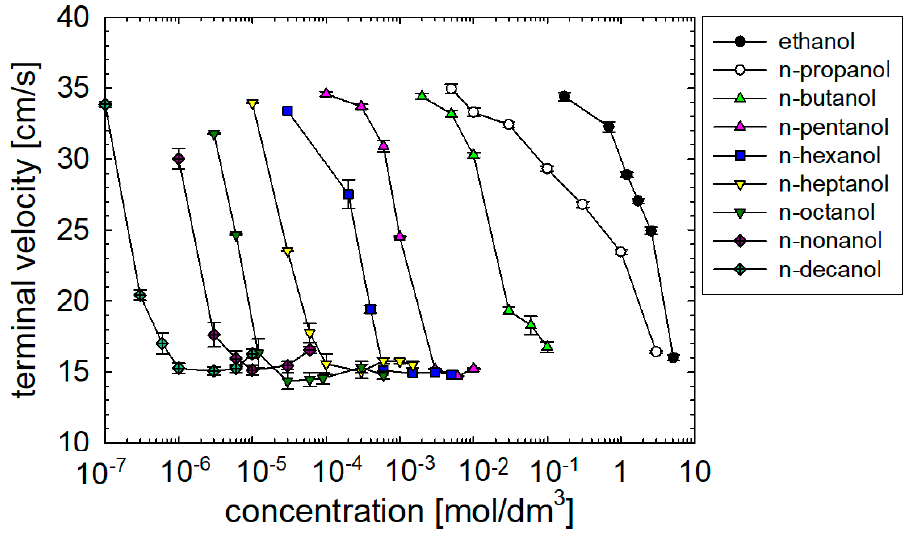
Figure 8. Terminal velocity of bubbles in n-alkanol solutions as function of their concentration. All bubbles with detachment time = 1.6 s. bubbles with detachment time = 1.6